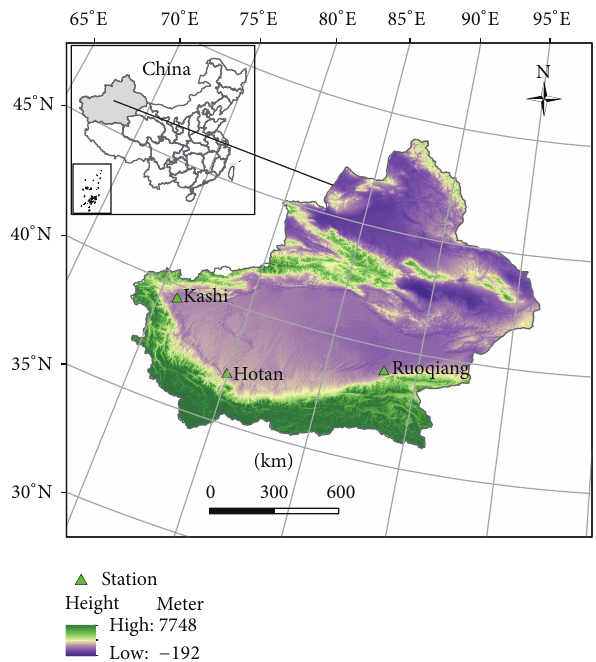
Figure 1: The sketch map of study area in Xinjiang,